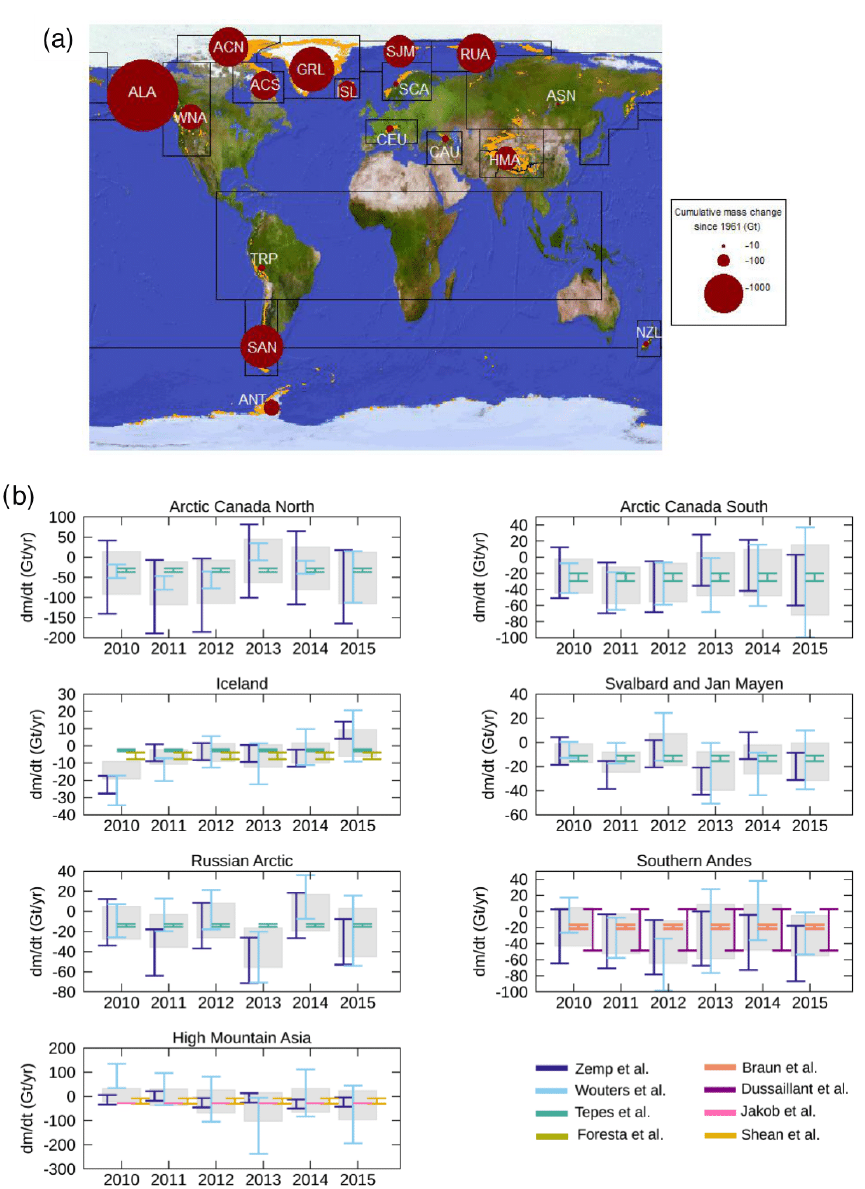
Figure 2. (a) Cumulative mass change for glacier regions (Gt) between 1962 and 2019. Outlines of the glacier regions (RGI 6.0) are marked by black lines and glacierized areas are indicated in orange: ACN, Arctic Canada North (area 105110km 2 ); ACS, Arctic Canada South (40888km 2 ); ALA, Alaska (86725km 2 ); ANT, Antarctic and subantarctic (132867km 2 ); CAU, Caucasus and Middle East (1307km 2 ); CEU, Central Europe (2092km 2 ); GRL, Greenland (89717km 2 ); HMA, High Mountain Asia (97606km 2 ); ISL, Iceland (11059km 2 ); NZL, New Zealand (1161km 2 ); RUA, Russian Arctic (51591km 2 ); SAN, Southern Andes (29429km 2 ); SCA, Scandinavia (2949km 2 ); SJM, Svalbard and Jan Mayen (33958km 2 ); TRP, low latitudes (2341km 2 ); WNA, Western Canada and USA (14524km 2 ). (b) Glacier rate of mass change (Gtyr − 1 ) in regions where estimates from different techniques are available, including satellite altimetry (Foresta et al., 2016; Jakob et al., 2020; Tepes et al., 2021), extrapolation of in situ glaciological and geodetic data (Zemp et al., 2019b, 2020), satellite gravimetry (Wouters et al., 2019), satellite InSAR (Braun et al., 2019), and satellite stereo imagery (Dussaillant et al., 2019b; Shean et al., 2020) over the period 2010–2015. The reconciled estimate (calculated as the average of the estimates available in a given region and year) is shown in